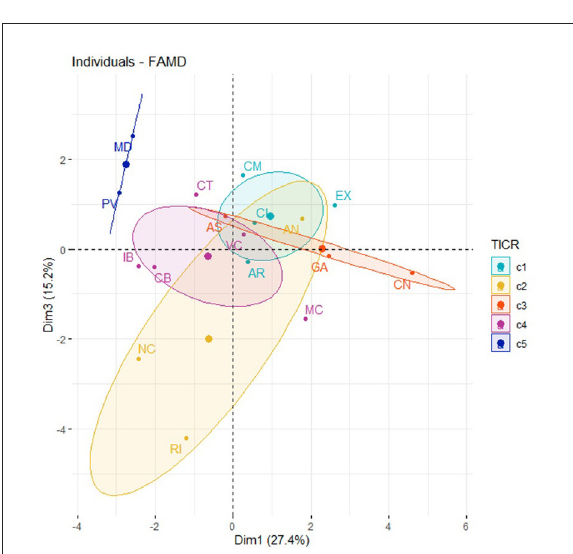
FIGURE9 Factor map of the ACS, Dimension 1, Dimension 5, and the